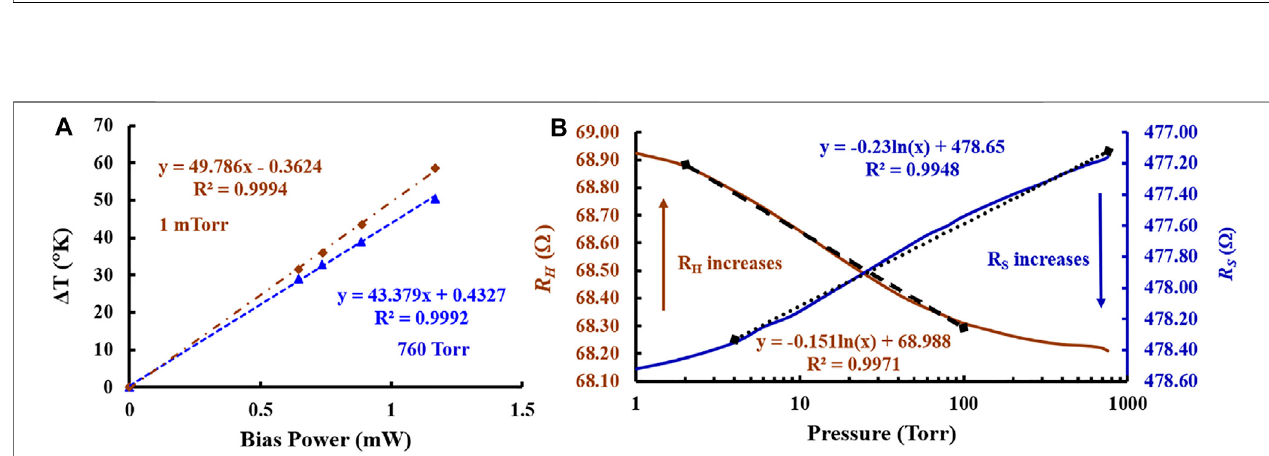
Frontiers in Mechanical Engineering |